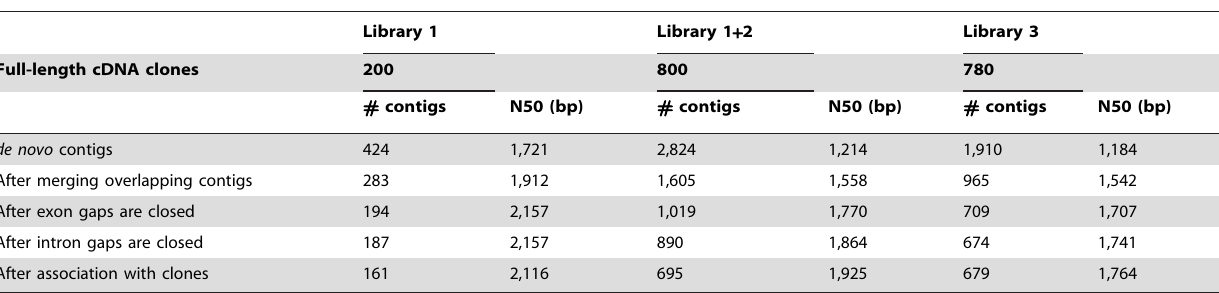
Table 1. Hybrid assembly statistics for individual